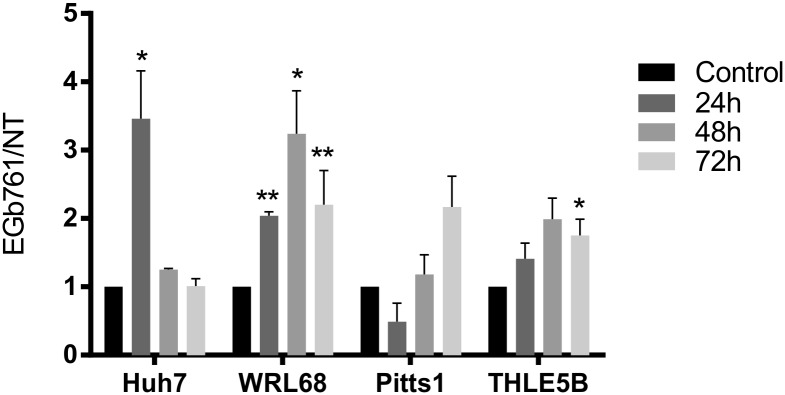
Nrf2 activation by EGb761.Time-dependent relative activation of nuclear Nrf2 in EGb761 treated cells normalized to untreated cells (control) of three independent experiments using the Nrf2 Transcription Factor Assay Kit (Colorimetric, Abcam) is demonstrated as means ± SD. *p<0.05, **p<0.01 analyzed by student’s t-test.